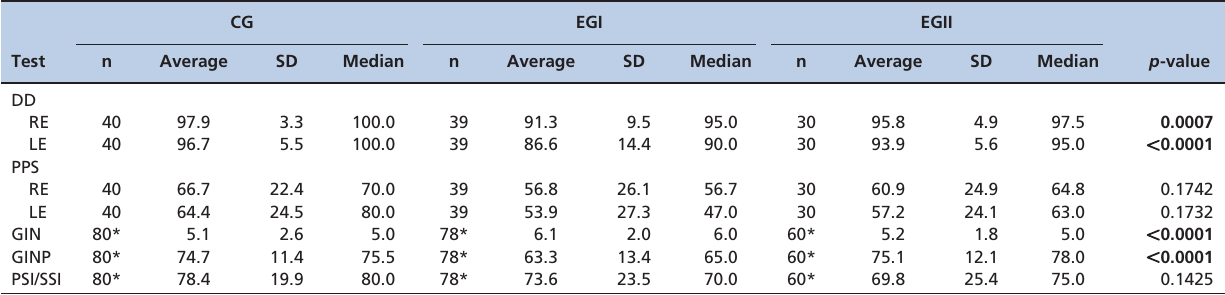
Table 2 - Student performance on (C)AP tests based on group. CG EGI EGII Test